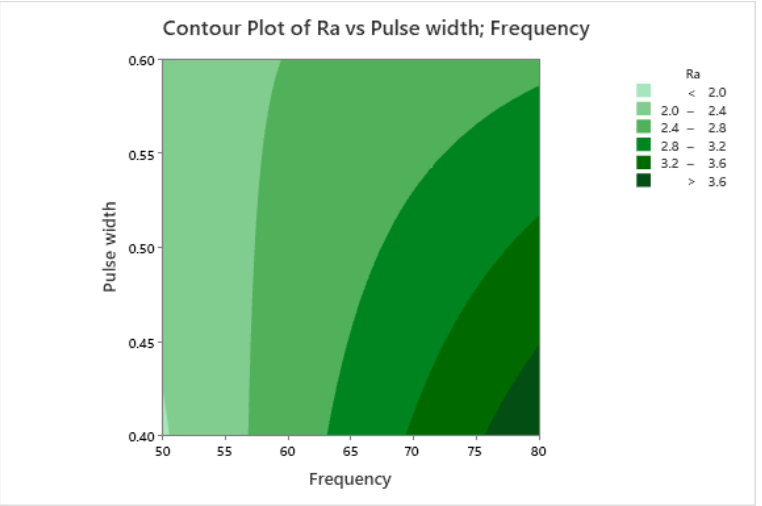
Figure 4. Contour plot of Ra vs. frequency and pulse width.